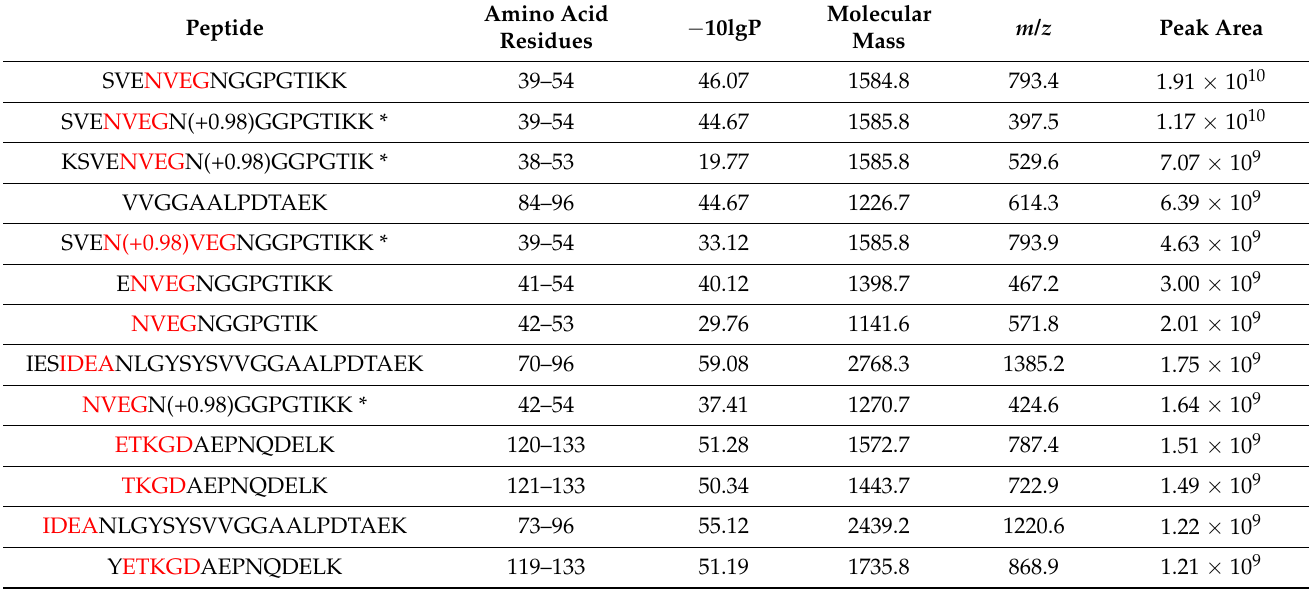
Table 2. The most represented proteolytic fragments (peak area > 1.0 × 10 9 ) of Gly m 4 identified using LC-MS/MS after the soybean allergen degradation for 8 h in vitro by lysosomal enzymes of human macrophages. Red color shows amino acid sequences of three dominant linear IgE- binding epitope fragments of Gly m 4 (N 43 VEG 46 , I 74 DEAN 77 and E 121 TKGD 125 , accordingly to